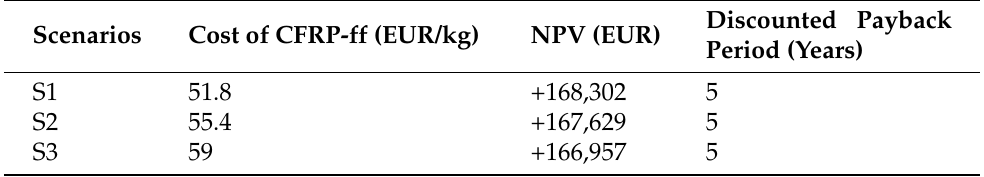
Table 17. Result of the economic assessment of the repair business of producer/remanufacturer for product made from CFRP-ff based on various ranges of material